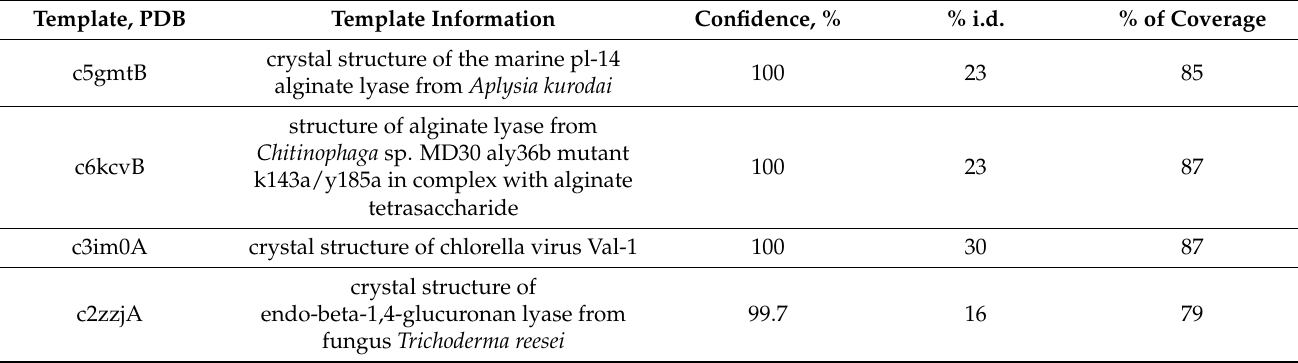
Table A1. Summary of Phyre2 top four templates for protein structure